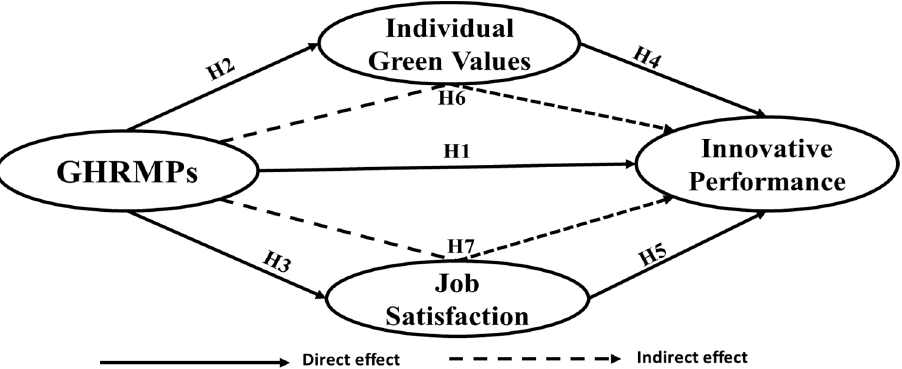
Figure 1. The proposed conceptual framework and hypotheses. GHRMPs → Green Human Resource Management Practices.